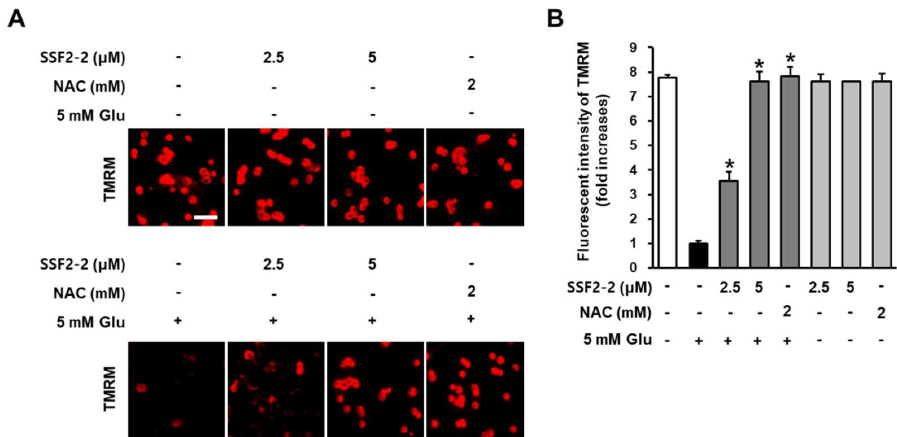
Figure 6. Effects of SSF2-2 on glutamate-induced depolarization of mitochondrial membrane potential. HT22 cells were incubated for 24 h with 5 mM glutamate (Glu) with or without compound SSF2-2 and N-acetylcysteine (NAC), and then stained with tetramethylrhodamine methyl ester (TMRM). ( A ) Fluorescent images collected using a fluorescent microscope. ( B ) Fold increases in fluorescent intensity of TMRM. White scale bar, 40 µ m. Data represent the mean ± S.E.M., n = 3, * p < 0.05 compared with the glutamate-treated group.